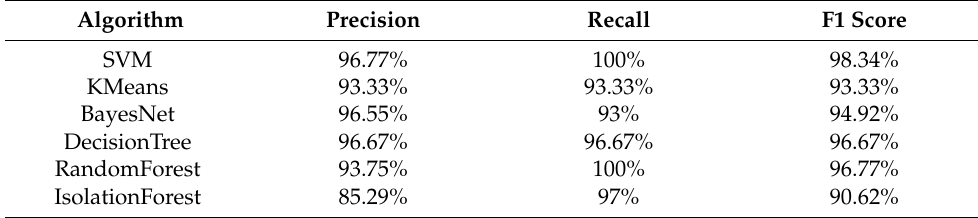
Table 3. Results of different detection algorithms.